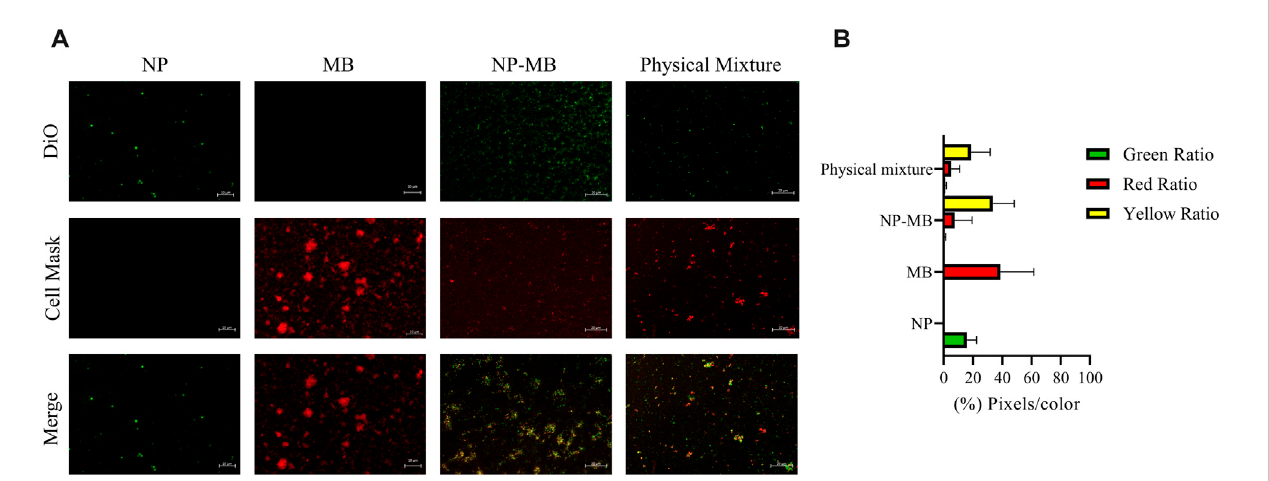
FIGURE 7 Confocal microscopy images recorded from NP, MB, NP-MB, and physical mixture (NP + MB) to identify visual evidence of the coating process. (A) Representative images recorded from NP, MB, NP-MB, and physical mixture for data processing. Green represented the fl uorescence of DiO dye ( λ em = 521 nm) and Red represented the fl uorescence of CellMask ™ Deep Red dye ( λ em = 670 nm). Scale bars = 20 μ m. (B) Data processing using a python programming language with OpenCV library for sample categorization.